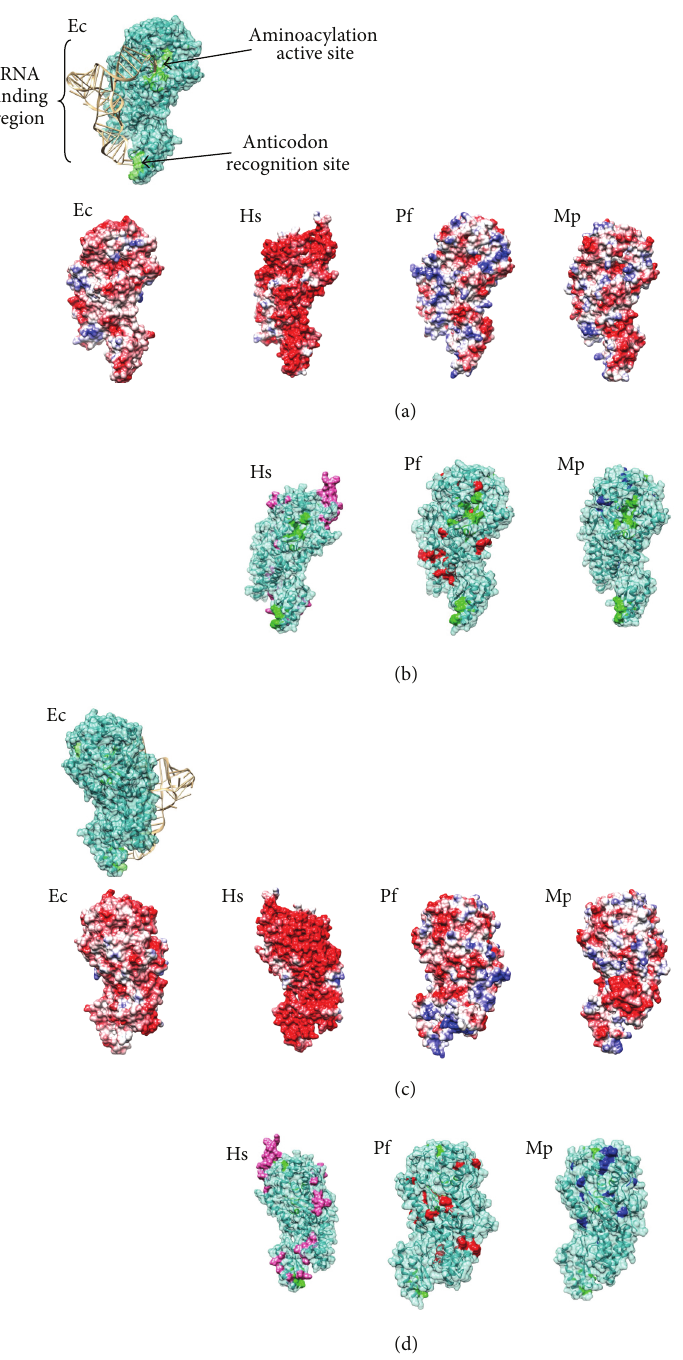
Figure 1: Graphical view of cysteinyl-tRNA synthetase with extremophilic protein adaptations. The homology models of Halobacterium salinarum (Hs), Pyrococcus furiosus (Pf), and Methanolobus psychrophilus (Mp) CysRS were generated based on the structure of Escherichia coli CysRS (see text for details). In the upper corner, the crystal structure of the Ec CysRS (PDB 1U0B, [10]) is provided for orientation and description of the enzyme’s features. (a) and (c) Coulombic surface map of the models on the tRNA side and back of the molecule, respectively. The Coulombic surface maps the amino acid electrostatic potential (according to Coulomb’s law) on surface residues: red is a negative potential, blue is a positive potential, and white indicates a relatively nonpolar potential. (b) and (d) The conserved features (in green) and unique adaptations highlighted on the surface of the models on the tRNA side and back of the molecule, respectively. The corresponding adaptations have been noted in the sequence alignment in Figure S1 (See Figure S1 in the Supplementary Material available online at http://dx.doi.org/10.1155/2013/373275). Unique features are highlighted in different colors for the different extremes: halophilic adaptations are in pink, the thermophilic adaptations are in red, and the psychrophile adaptations are in blue. The molecular graphics were created with the USCF Chimera package